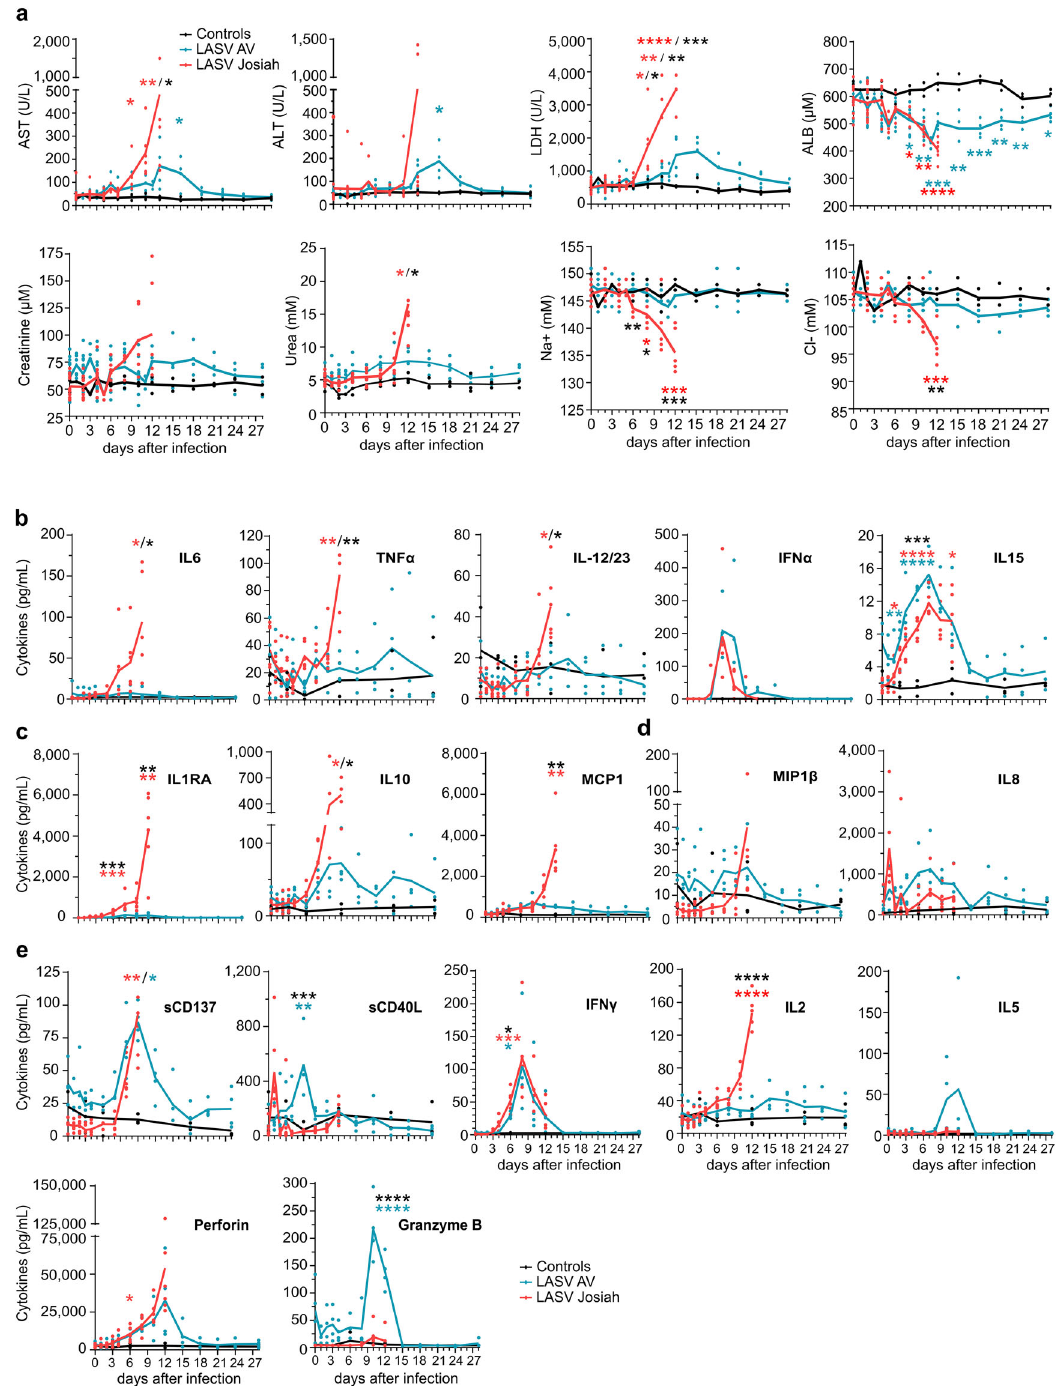
Fig. 3 Biochemical and in fl ammatory responses monitoring after LASV challenge. a Analysis of biological parameters during LASV infection. The data from longitudinally followed and sequentially killed animals at 2, 5, and 11 DPI were collected: controls ( n = 3 animals), LASV-AV ( n = 10), LASV-Josiah ( n = 12). The individual data at the time before the death of all longitudinally followed LASV-Josiah-infected primates were collected to calculate the mean determined at 12 DPI. Results show the mean (curve) and individual data points for each group. Statistical analyses were performed and are presented as in Fig. 1. Quanti fi cation of pro-in fl ammatory cytokines b , anti-in fl ammatory cytokines c , chemokines d , and T-cell response-related mediators e in plasma according to the time after LASV infection. b – e Results show the mean (curve) and individual data points for each group: controls ( n = 3), LASV-AV ( n = 4), LASV-Josiah ( n = 6). Statistical analyses were performed and are presented as in Fig.